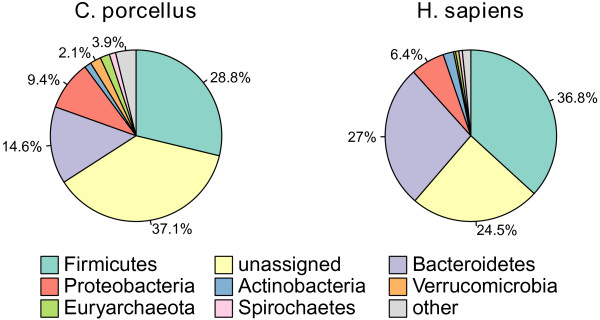
Distribution of Phyla present in humans and guinea pigs. Bacterial phyla found in the intestinal microbiota of humans (H. Sapiens) and guinea pigs (C. porcellus), by PhymmBL annotation excluding unassigned reads. The fraction marked unassigned could not be assigned to a specific phylum.